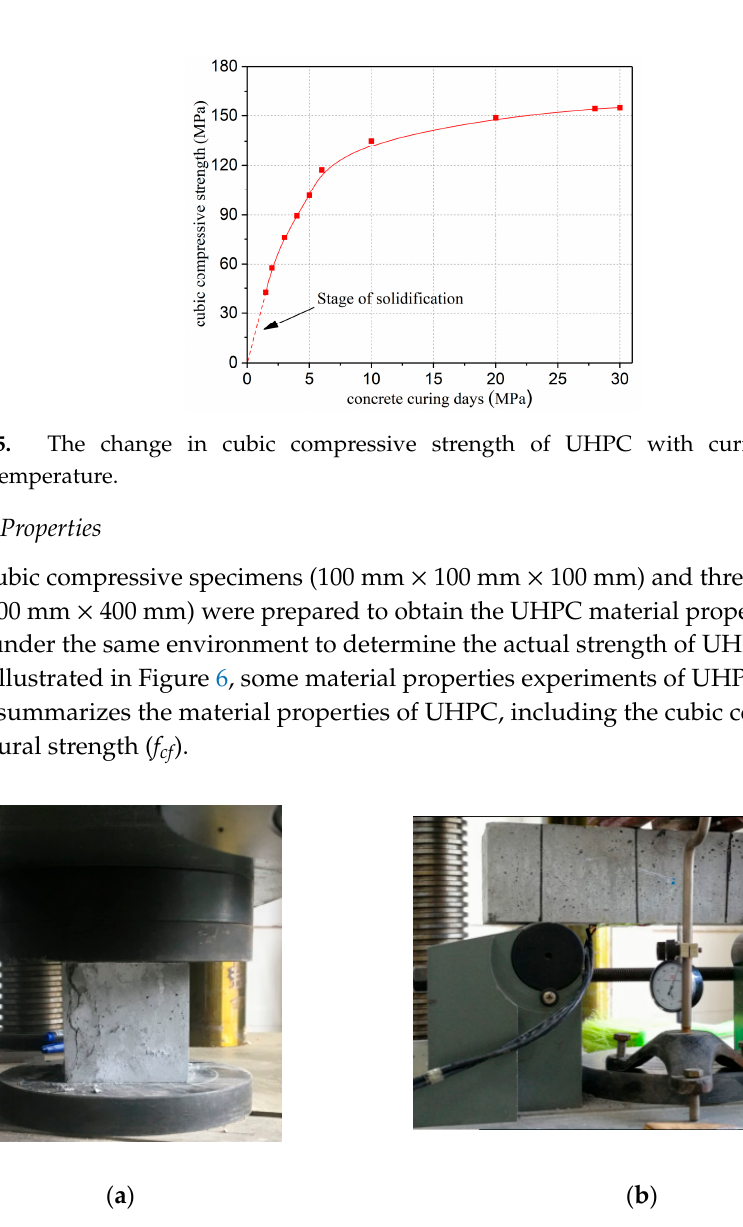
test. Table 4. Test results of the UHPC materials (unit: